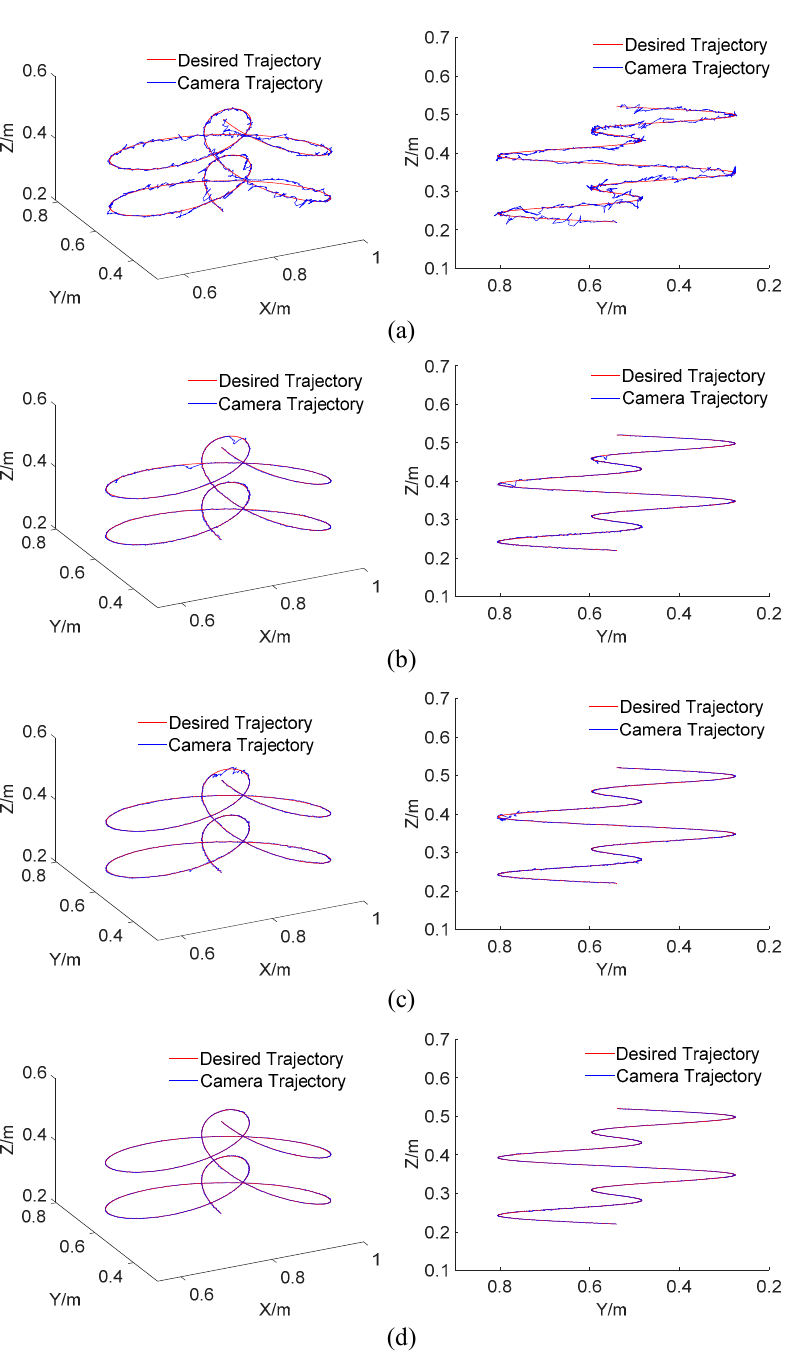
Figure 9. Camera trajectories of different strategies in a triple leaf rose path. ( a ) Camera trajectory of IBUVS. ( b ) Camera trajectory of the original PHUVS. ( c ) Camera trajectory of the improved PHUVS with the KF method. ( d ) Camera trajectory of the improved PHUVS with the KF-SVSF method.